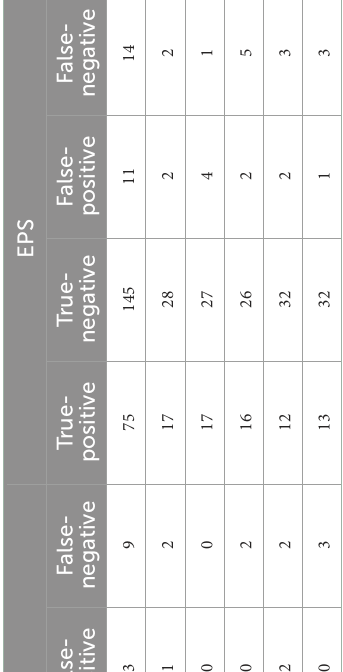
TABLE 1 Demographic characteristics of 49